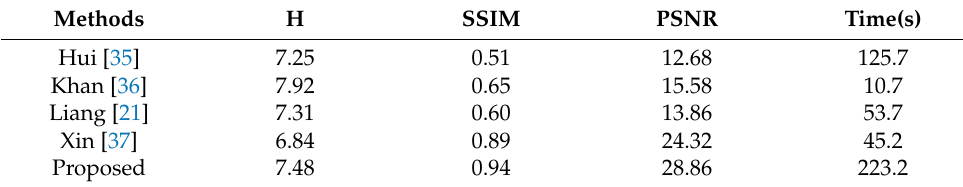
Table 2. Objective values of the images shown in Figure 5.